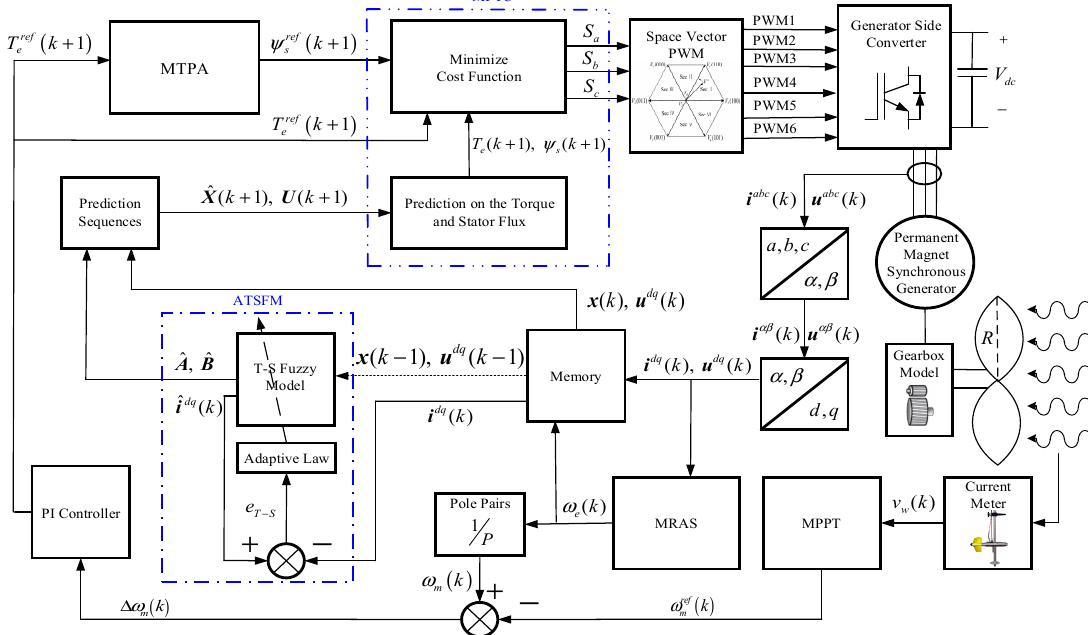
Figure 3. Block diagram of the proposed adaptive T–S fuzzy model predictive control (ATSFMPC) architecture.